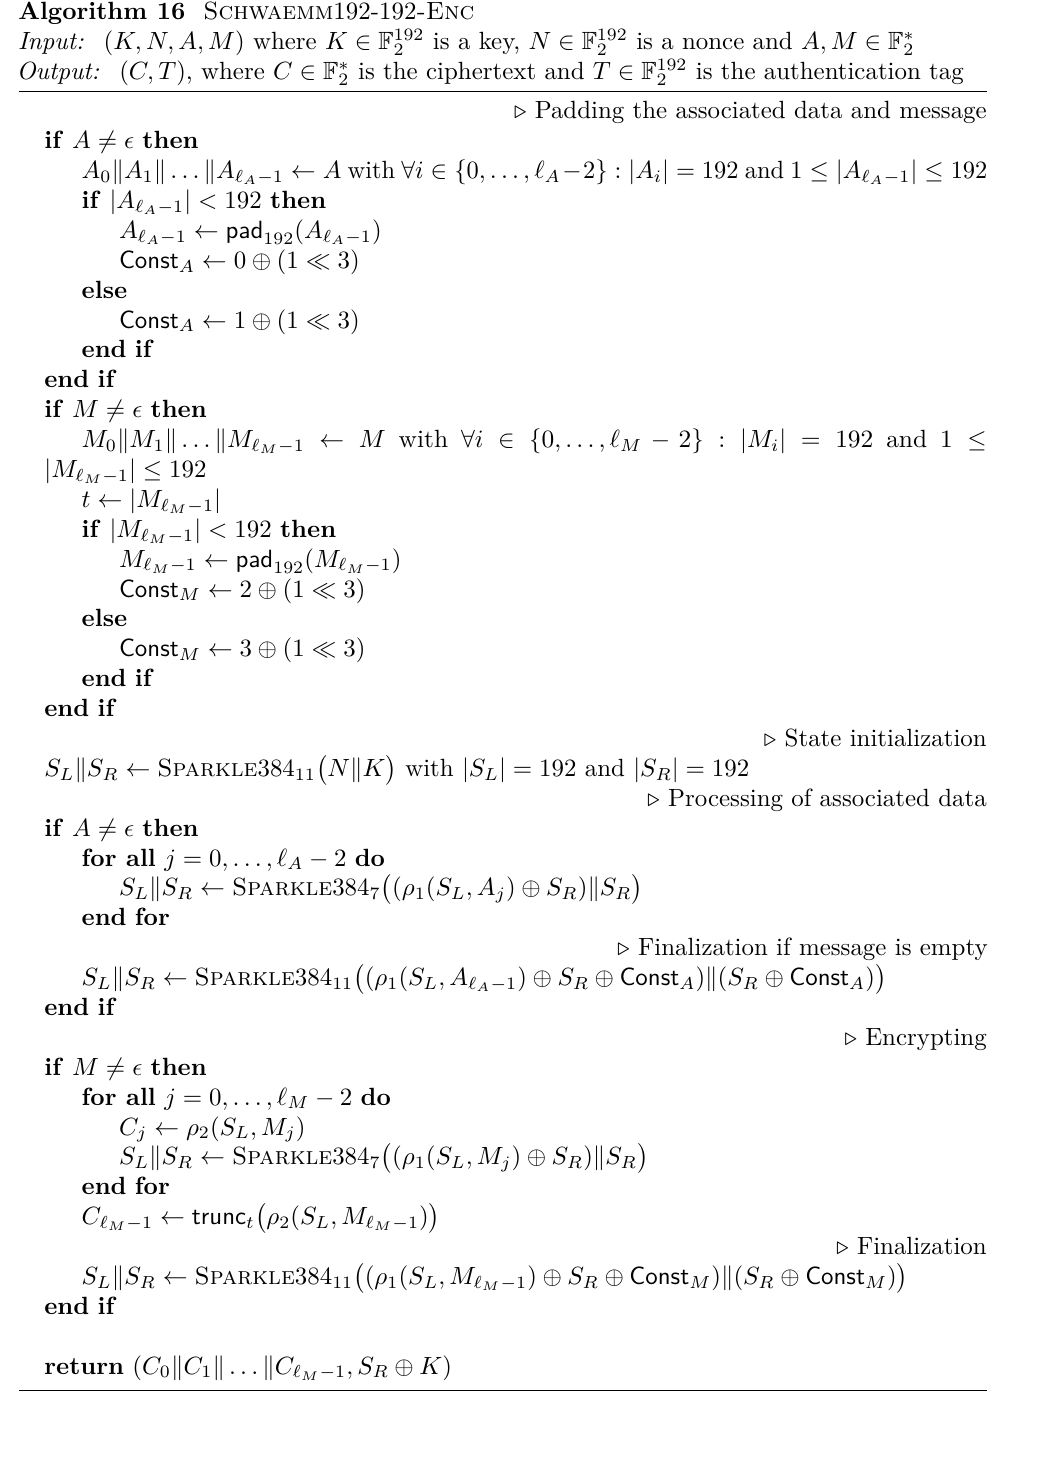
Algorithm 16 Schwaemm 192-192